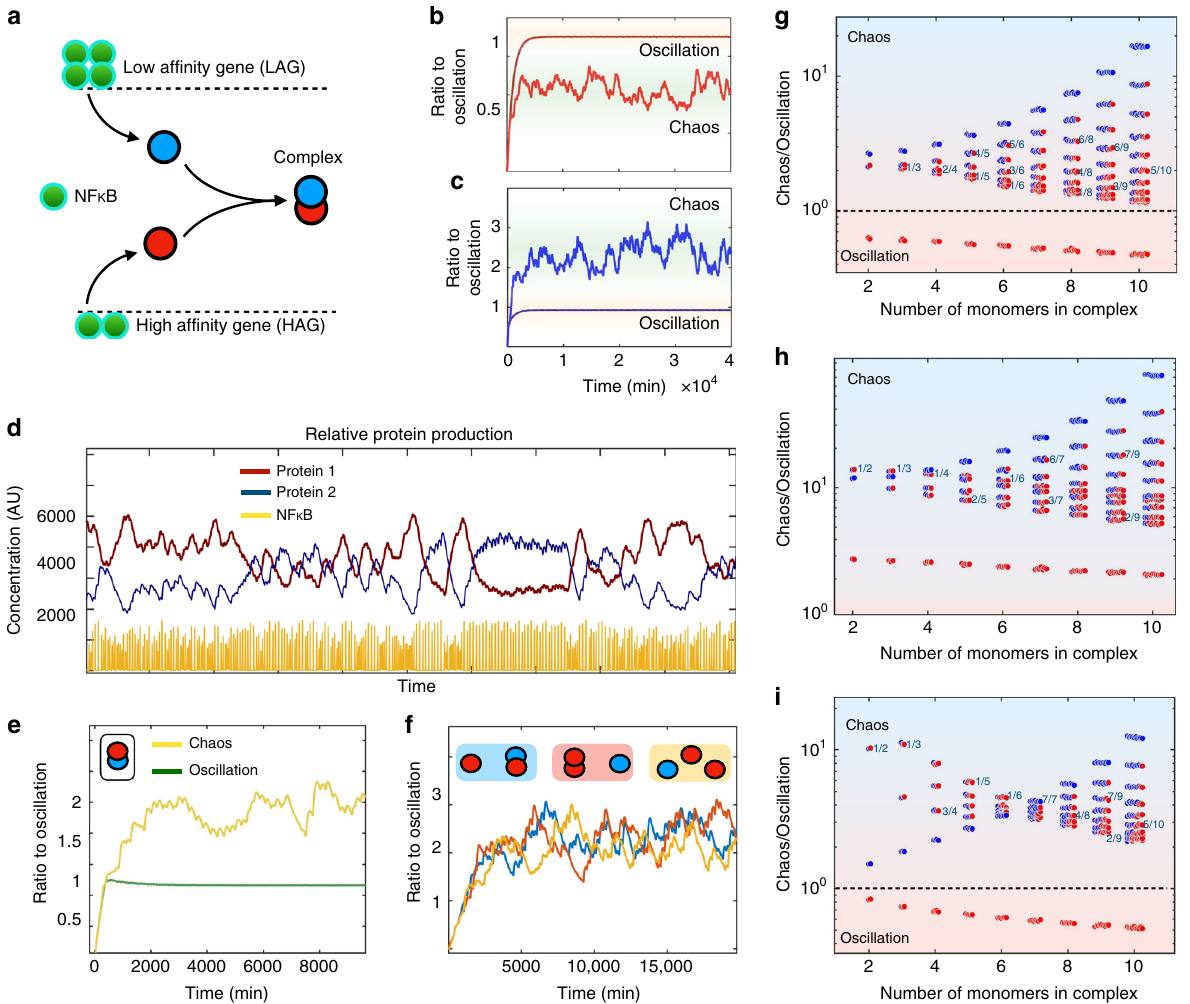
Fig. 3 Effects of chaos on protein complex formation. a Schematic picture of how LAG and HAG encoded proteins may form protein complexes. b Protein concentration for HAG ( K = 1, h = 2) with oscillatory and chaotic dynamics, respectively. T TNF = 50 min. c Protein concentration for LAG with ( K = 4.5, h = 4) oscillatory and chaotic dynamics, respectively. T = 50 min. d Time series of NF- κ B (yellow) and the corresponding protein level. Red: Level of TNF HAG protein. Blue: Level of LAG protein (multiplied by 20). T TNF = 50 min. e Concentration of a heterogenous two-protein complex (shown upper left) with oscillatory and chaotic dynamics respectively. f Concentration of a heterogenous three-protein complex in chaotic dynamics depending on the hierarchical assembly (shown above). g Relative concentration for complexes of different compositions. The y -axis show the concentration in chaos divided by the concentration in the oscillatory regime, and the black line show where these are equal. h Relative concentration per NF- κ B for complexes of different h C N ; n compositions measured by the fraction H C N ; n measured by the fraction H